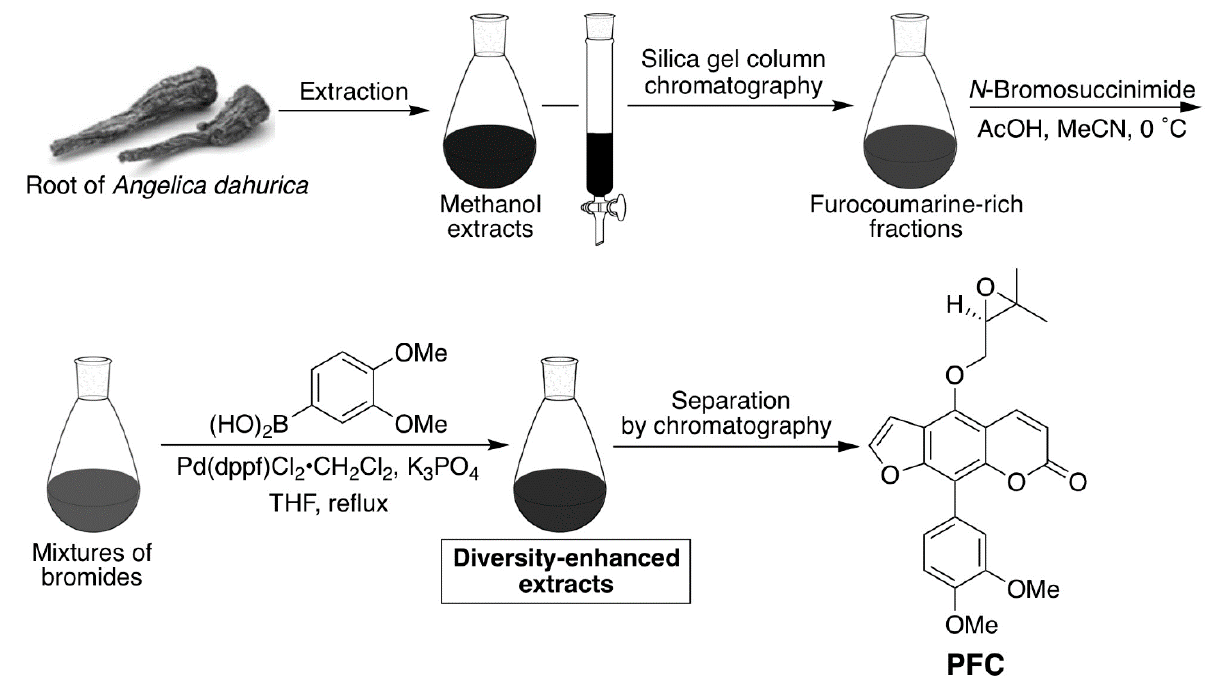
Figure 5. PFC synthesis scheme.